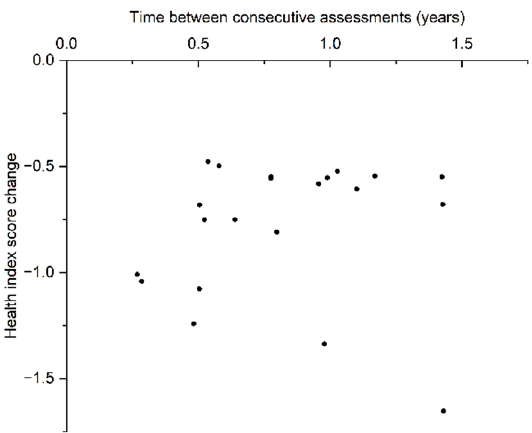
Figure 7. The major negative changes in the health index value between the successive measure-